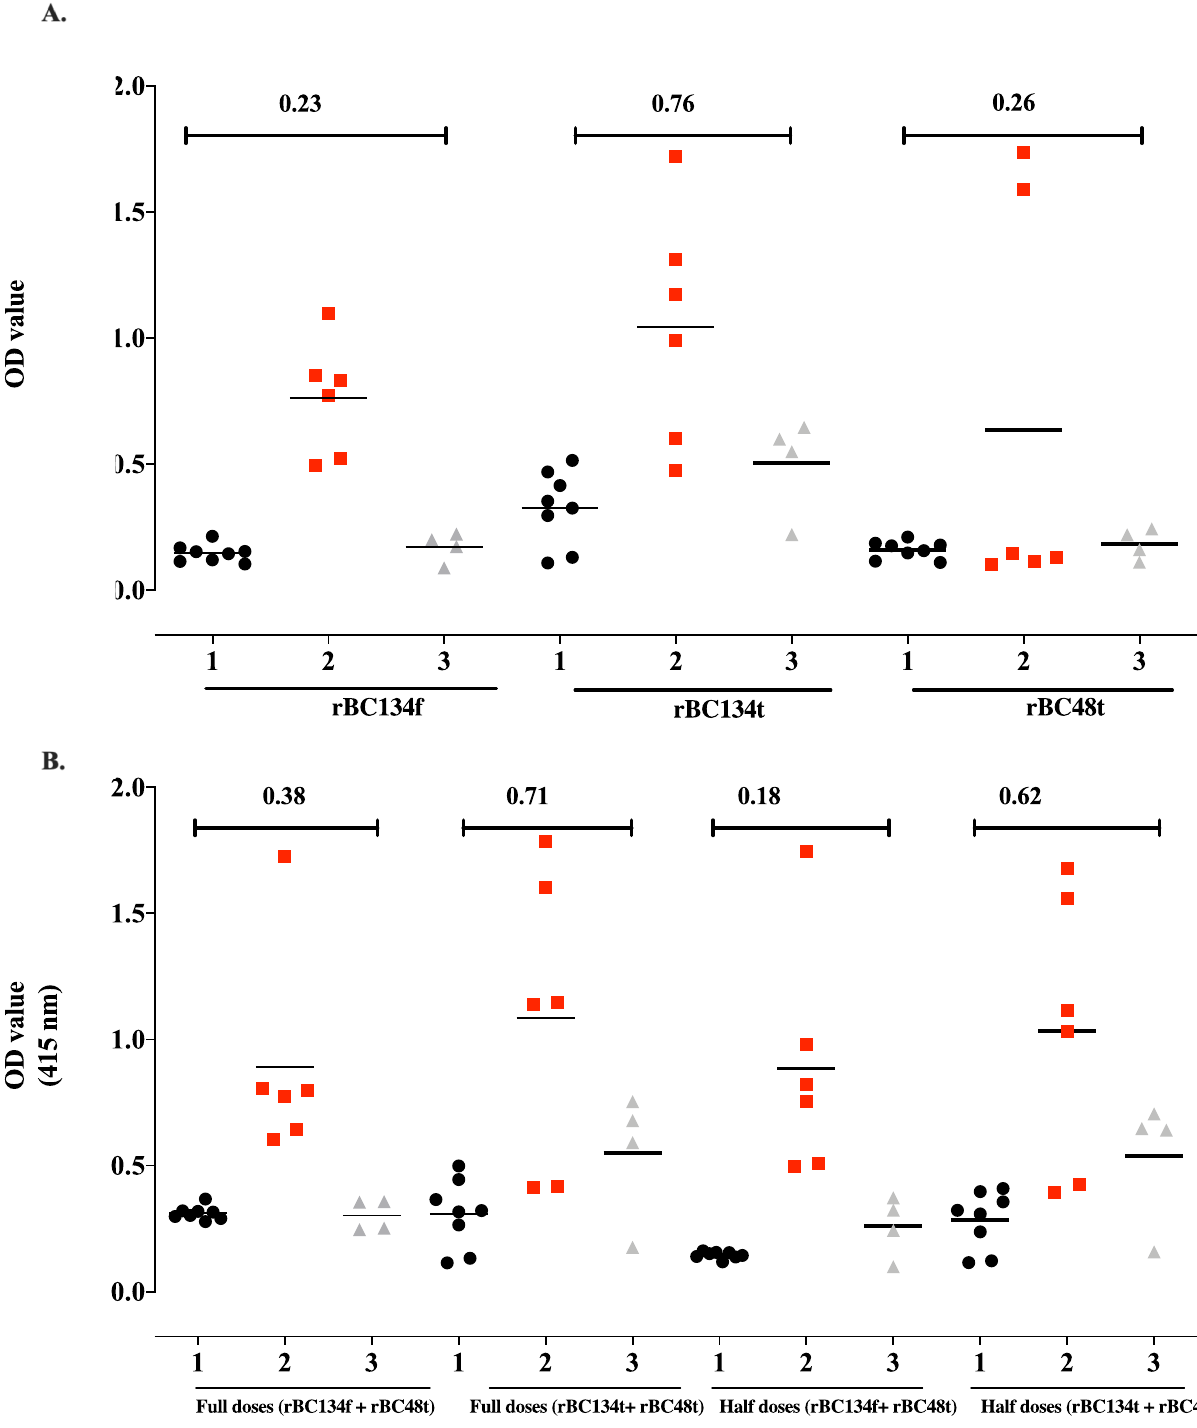
Fig 1. Reactivity of the iELISA using recombinant proteins with horse sera. Lanes: 1, uninfected horse sera (black circle); 2, sera experimentally infected with B . caballi (red square); 3, sera experimentally infected with T . equi (Grey tri-angle). The cutoff of each recombinant protein is indicated by a bar. The serum samples were collected at day 18 post